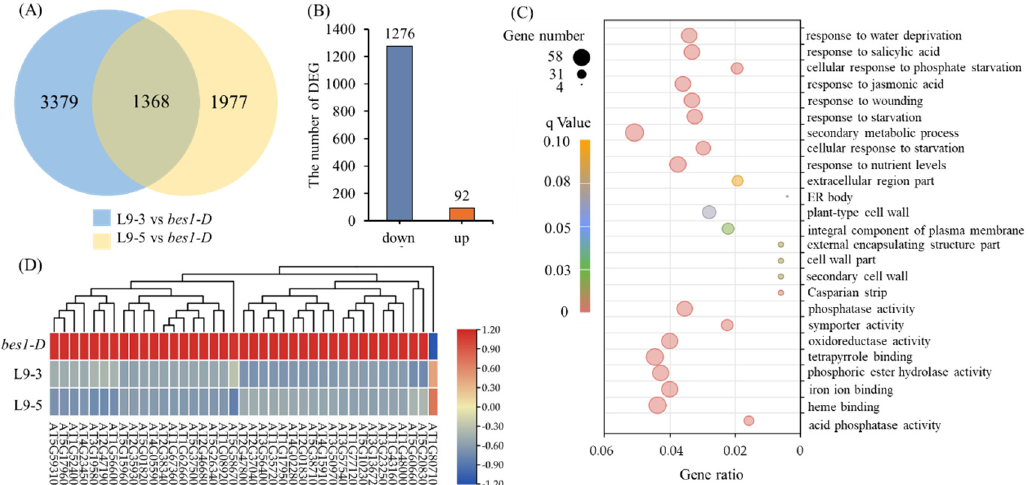
Figure 7. DEGs of transgenic Arabidopsis with the ZmBES1/BZR1-9 gene compared to bes1-D . ( A ) DEGs of L9-3 and L9-5 compared to bes1-D , respectively. ( B ) The common DEGs are shared by L9-3 and L9-5. ( C ) GO analysis of common DEGs. ( D ) The heat map of the 39 DEGs responds to water deprivation.